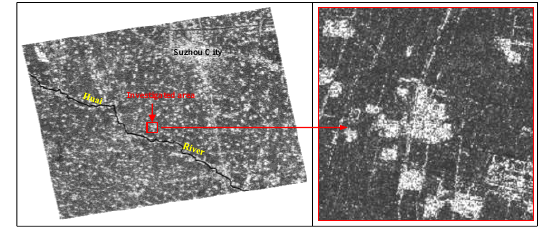
Figure 1. SAR amplitude image of investigated